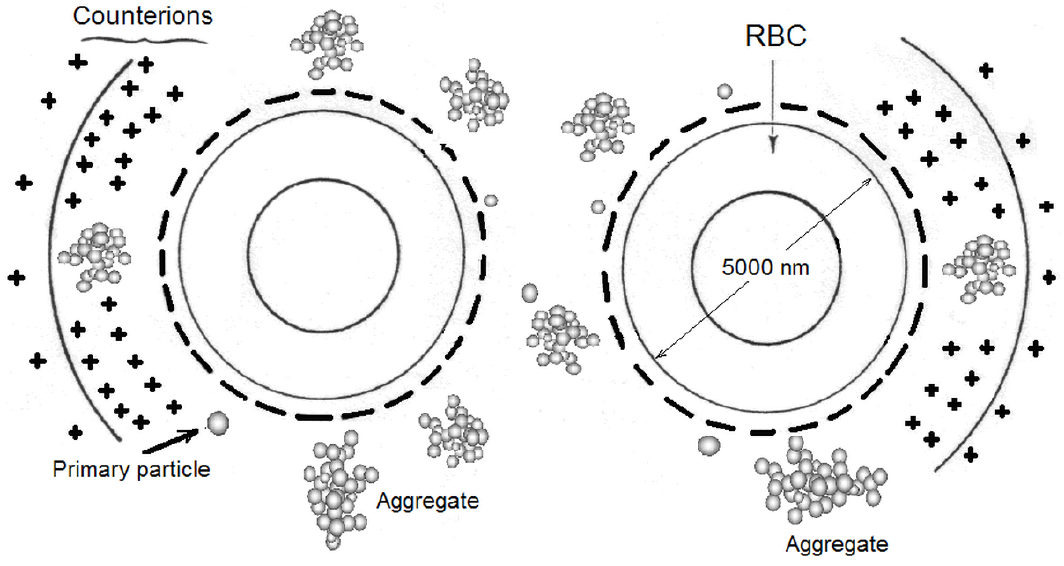
Fig. 3 Model of agglutination of RBCs with the participation of aggregates with primary silica